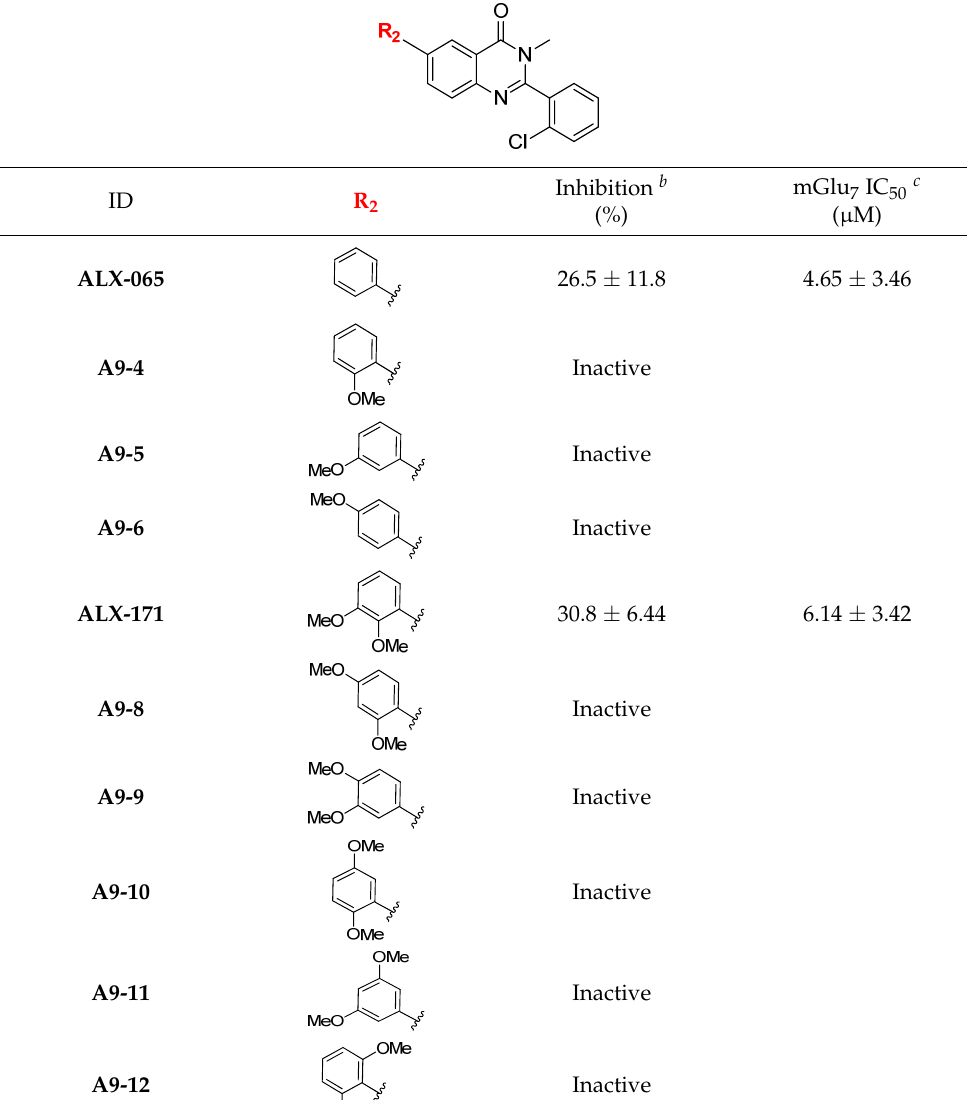
Table 1. Structures and in vitro mGlu 7 receptor NAM activity of selected 2,6-disubstituted(3 H )- quinazolin-4-ones a .